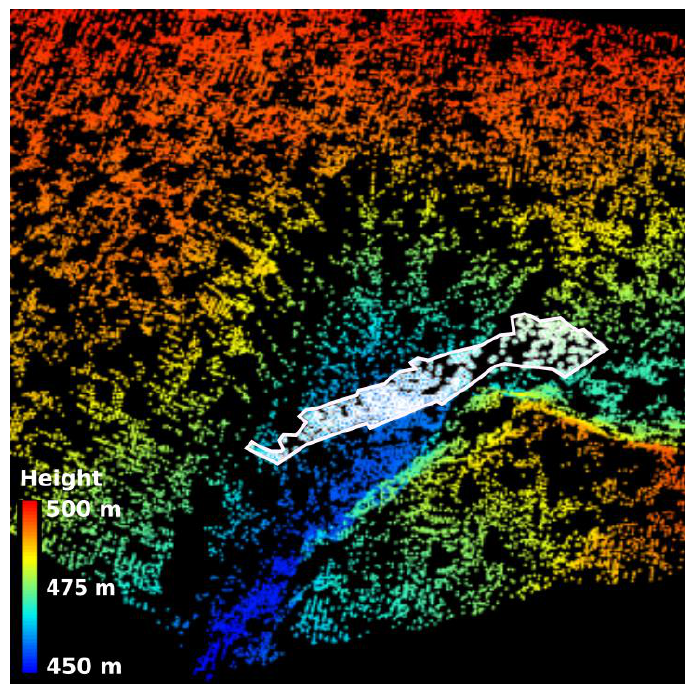
Figure 4. Locations of points used to calculate aspect for one west-facing rock wall where ALS ground points are colored using height and identified rock wall is colored white when matching ground reference data.